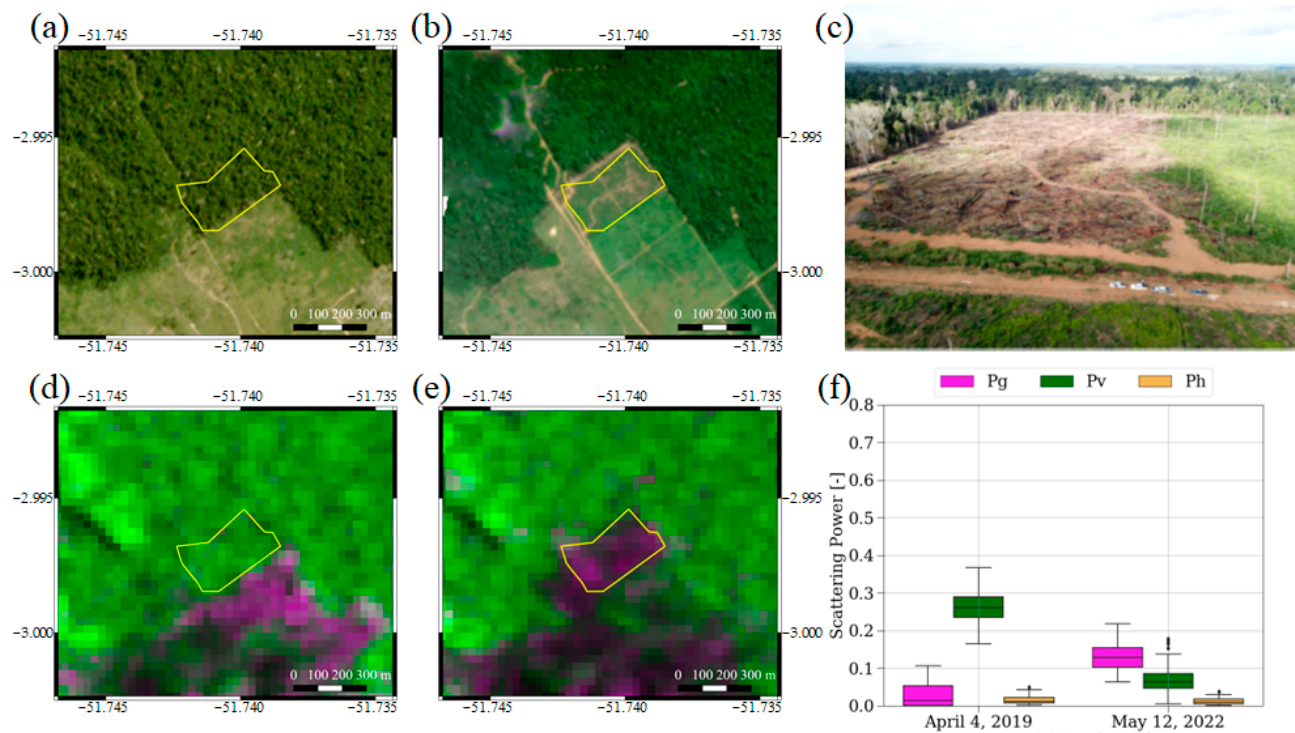
Figure 8. Deforestation at Altamira detected by using the proposed method with actual dual-polarization data acquired on 4 April 2019 and 12 May 2022. The yellow outline shows the area detected by the proposed method. Mosaic images acquired by Planet/Dove in ( a ) June–November 2019 and ( b ) April 2022. ( c ) Drone image of the detected area acquired in February 2022. RGB images generated by the proposed method using dual-polarization data acquired on ( d ) 4 April 2019 and ( e ) 12 May 2022. Ground scattering is indicated in red and blue, and volume scattering is in green. ( f ) Box and whisker plot of the scattering power components using pixels in the yellow outline. The whiskers extend to 1.5 times the interquartile range.